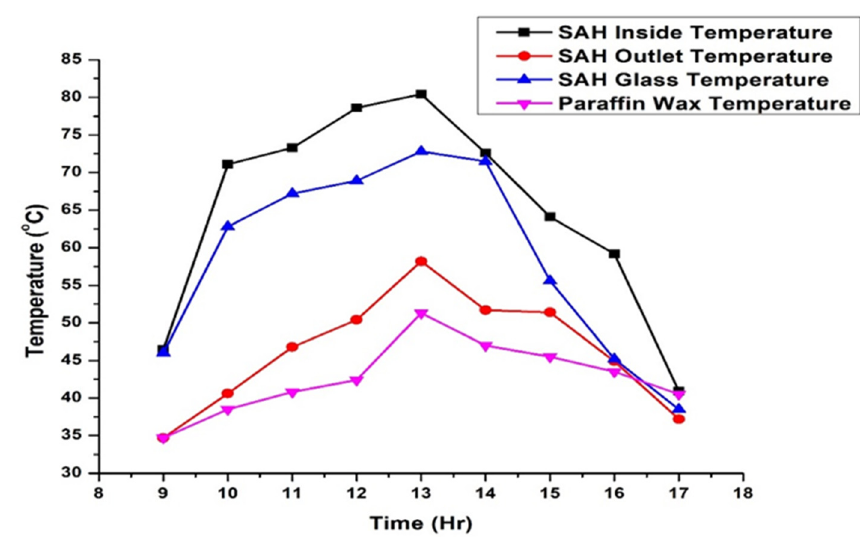
Figure 6. Variation of SAH and Paraffin wax temperature vs. time.